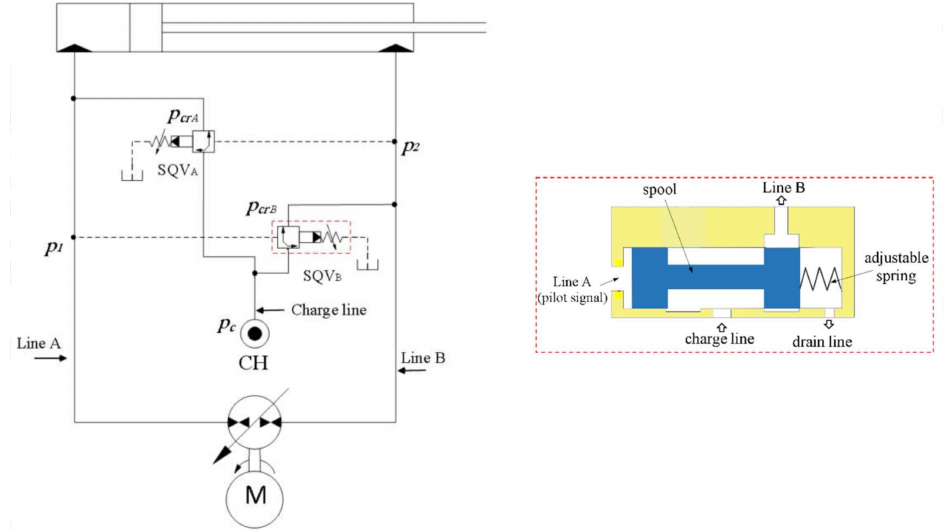
Figure 9. Circuit with limited throttling valves that uses two sequence valves; inset shows cross-section drawing of SQV B . SQV, sequence